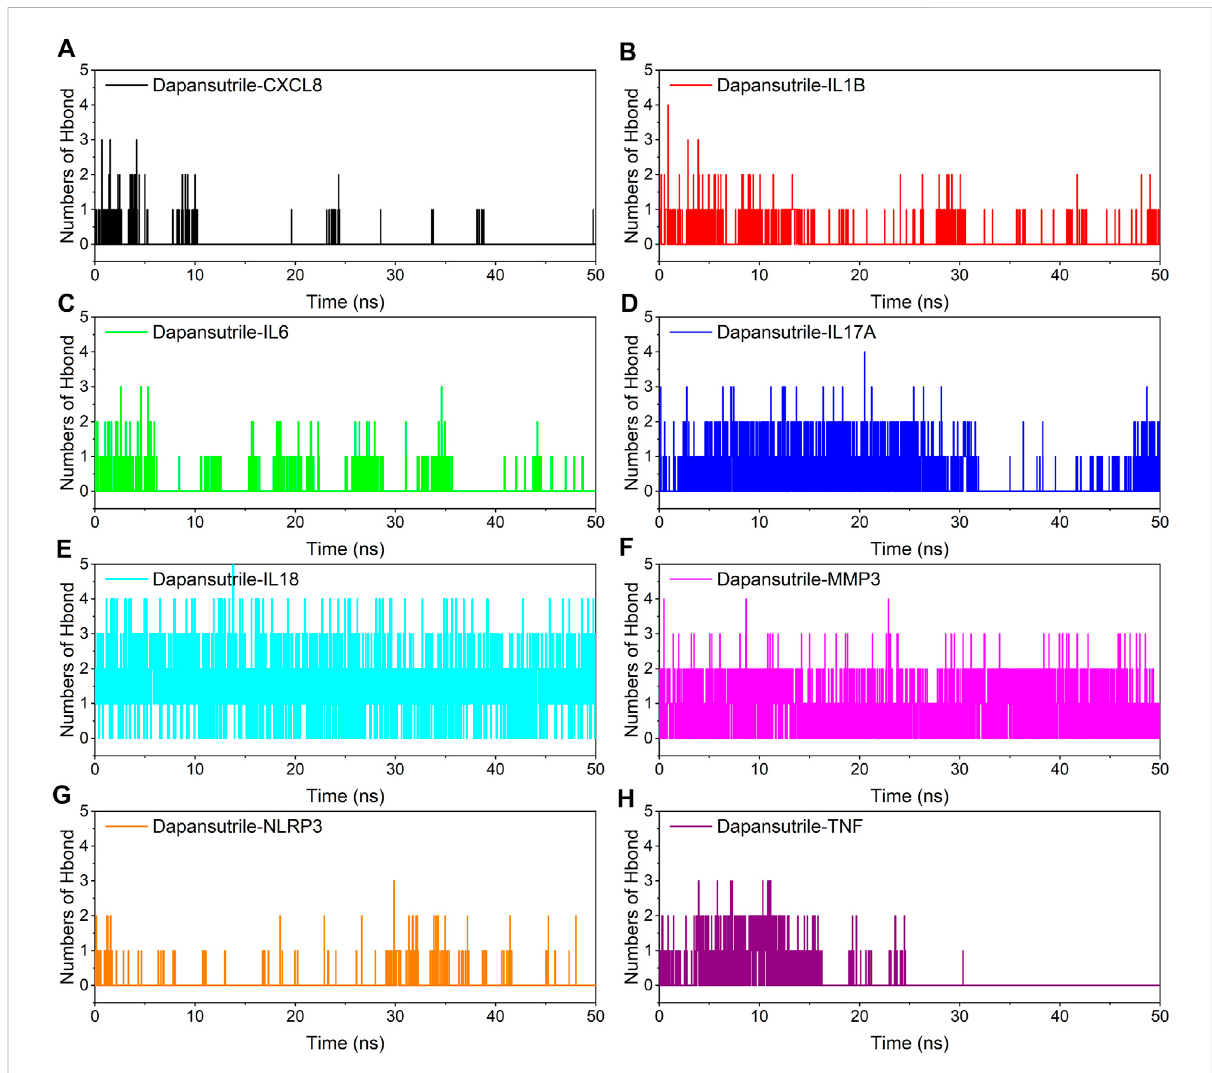
FIGURE 6 Changes in the number of hydrogen bonds between small molecule ligands and protein receptors in complex system simulations (A) Dapansutrile/CXCL8, (B) Dapansutrile/IL1B, (C) Dapansutrile/IL6, (D) Dapansutrile/IL17A, (E) Dapansutrile/IL18, (F) Dapansutrile/MMP3, (G) Dapansutrile/NLRP3, (H)